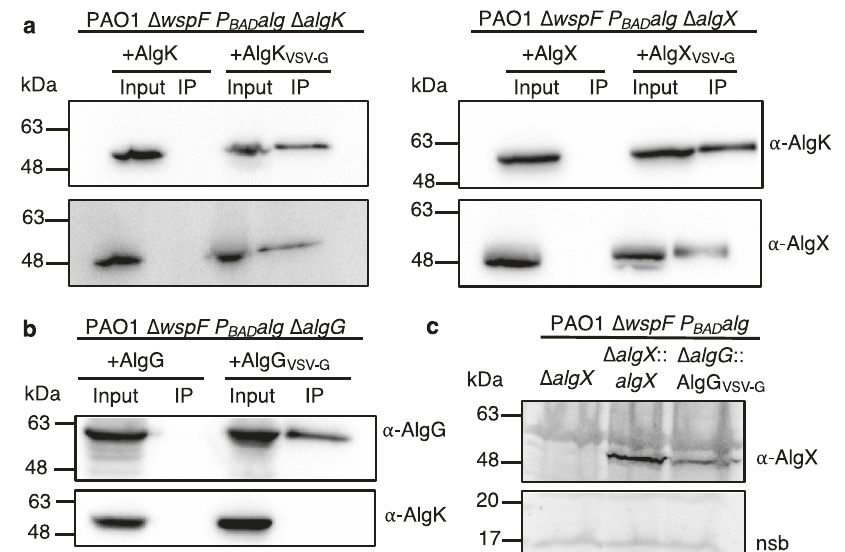
Fig. 4 | AlgK and AlgG do not interact in vivo in P. aeruginosa . a Co- immunoprecipitation studies from whole cell lysates with untagged and VSV-G- tagged AlgK Pa (left), and untagged and VSV-G-tagged AlgX Pa (right) as the bait. This experiment was repeated independently one other time. b Co- immunoprecipitation studies from whole cell lysates with untagged and VSV-G- taggedAlgG